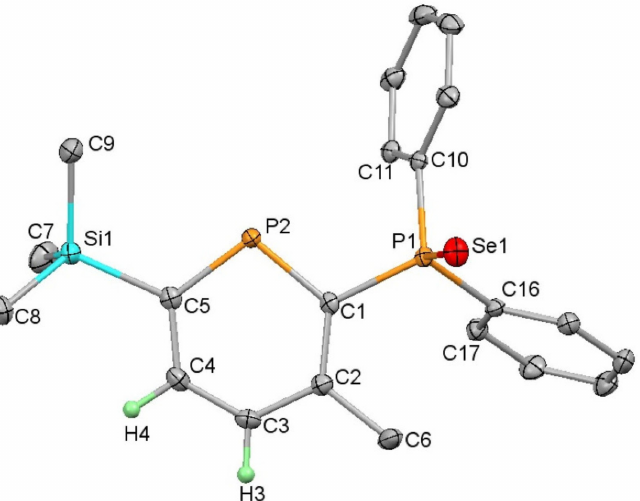
Figure 3. Molecular structure of 9 (thermal ellipsoids at 50%; all H atoms except for those attached to the heterocyclic ring have been omitted for clarity). Selected bond lengths (Å) and angles ( ◦ ): Se1-P1 2.1132(4); P2-C1 1.7516(17); C1-C2 1.407(2); C2-C3 1.397(2); C3-C4 1.386(2); C4-C5 1.403(2); P2-C5 1.7282(18); P1-C1 1.8235(17); C5-P2-C1